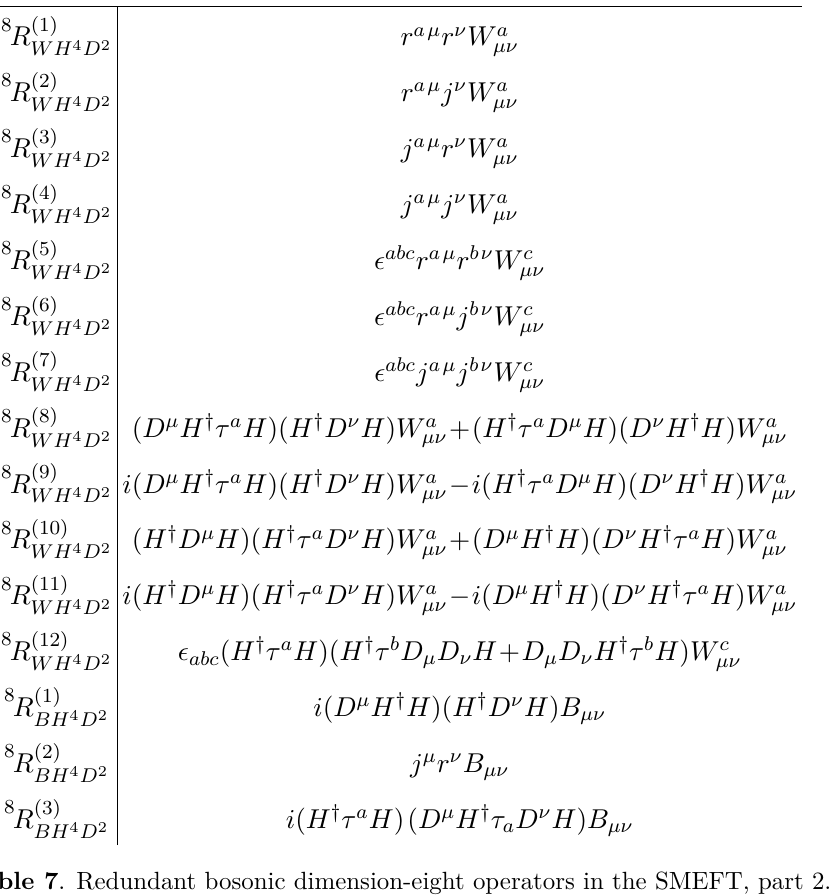
Table 7 . Redundant bosonic dimension-eight operators in the SMEFT, part